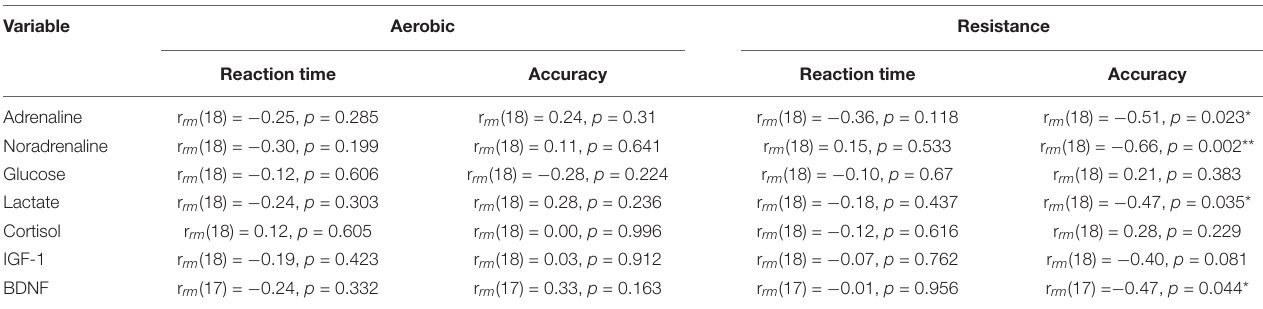
TABLE 2 | Repeated measures correlation between cognitive performance (reaction time and accuracy) and peripheral biomarkers.